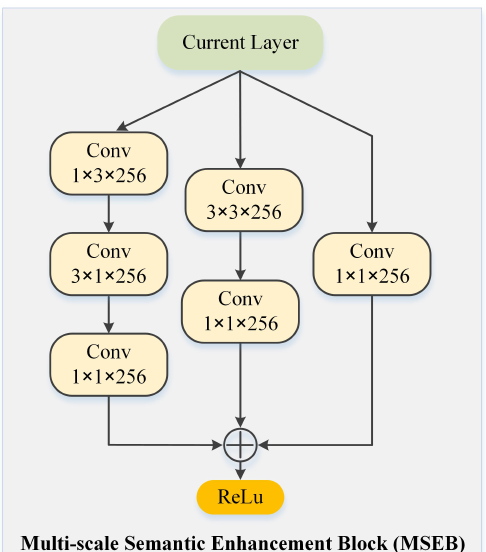
Figure 2. The proposed multi-scale semantic enhancement block